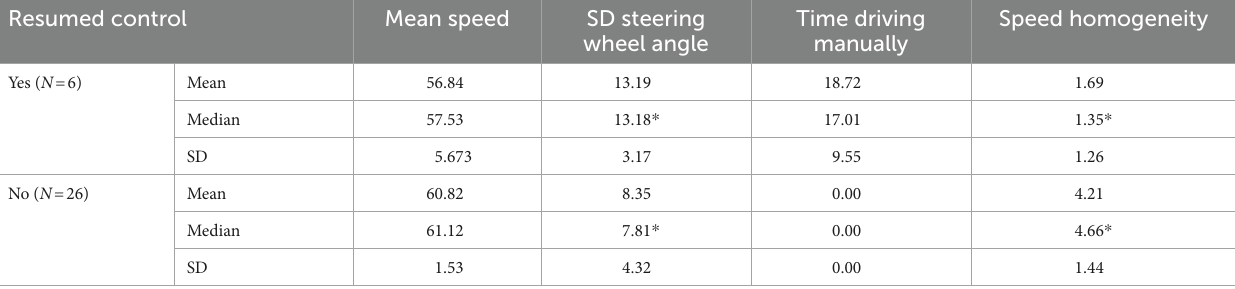
TABLE 1 Driving performance measures for the silent failure condition. Statistically significant effects are indicated with an asterisk ( * ). Resumed control